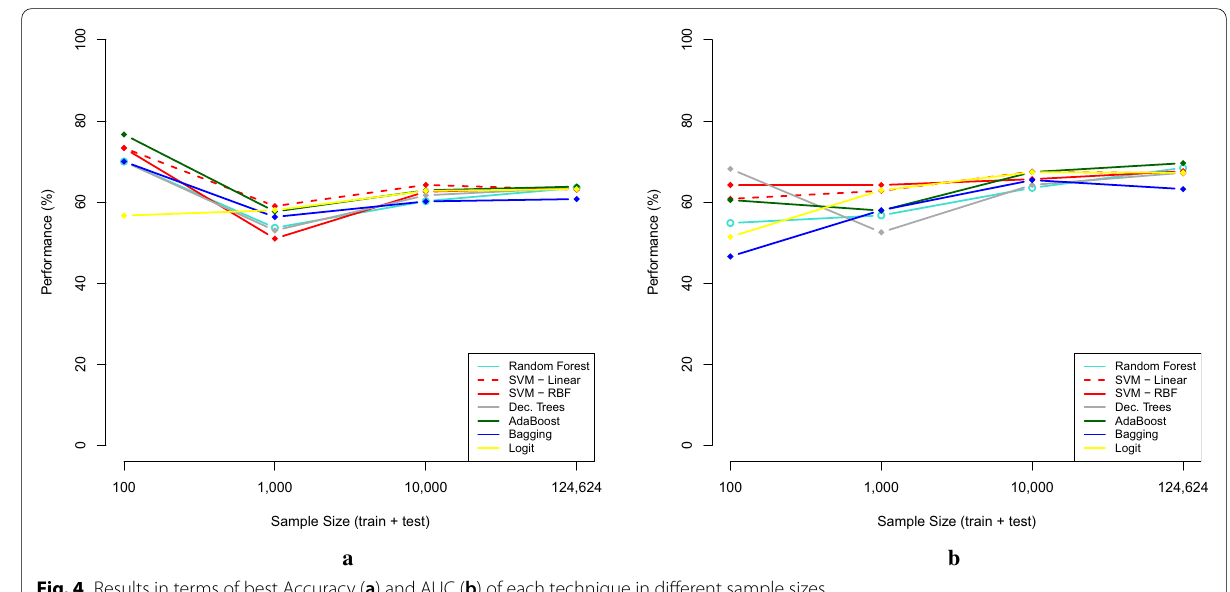
Fig. 4 Results in terms of best Accuracy ( a ) and AUC ( b ) of each technique in different sample